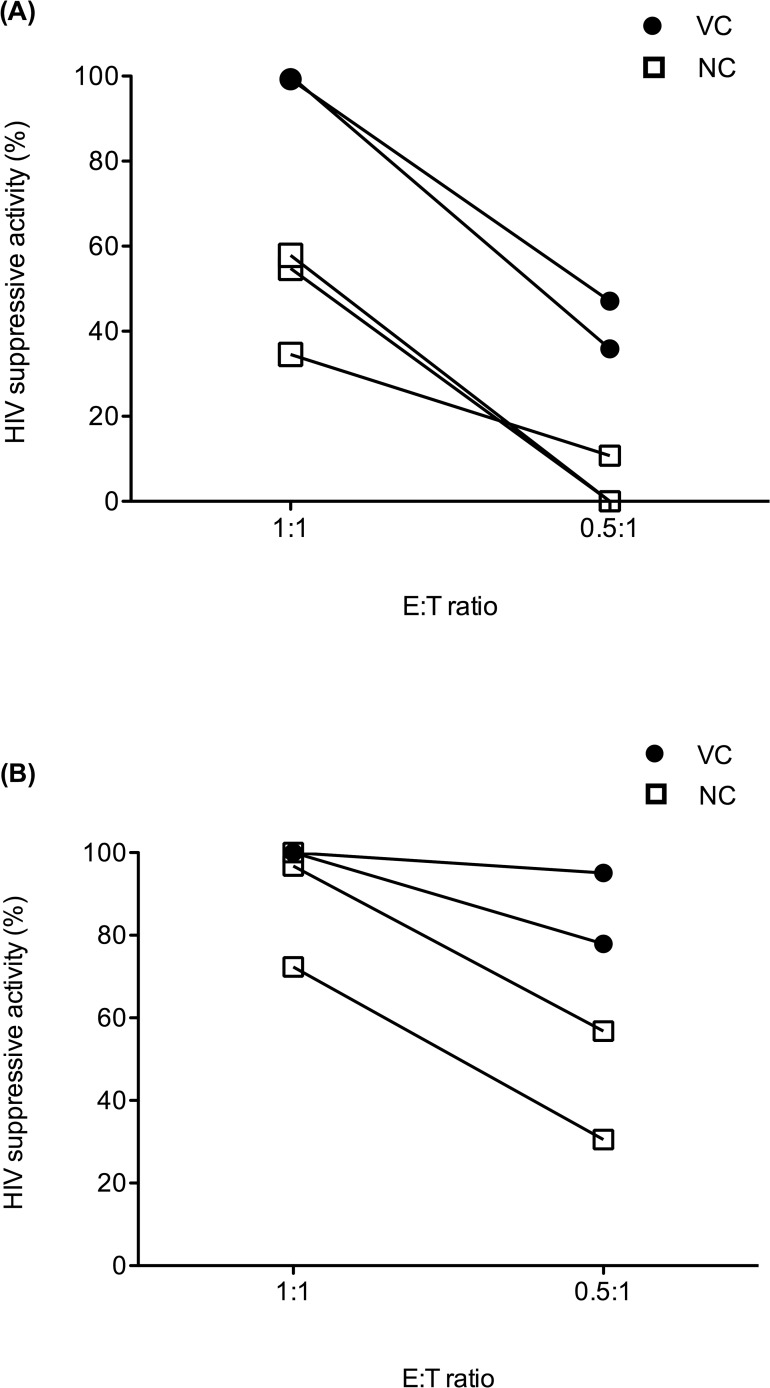

In vitro HIV suppression assay in various E:T ratios.
(A)
In vitro HIV suppression assay mediated by ex vivo unstimulated CD8+ T cells in culture with autologous CD4+ T cells at various E:T ratios of 1:1 and 0.5:1 in VC (N = 2, filled circle) and NC (N = 3, open rectangle). (B)
In vitro HIV suppression assay mediated by HIVp24-specific T cell lines at various E:T ratios of 1:1 and 0.5:1 in VC (N = 2, filled circle) and NC (N = 2, open rectangle).